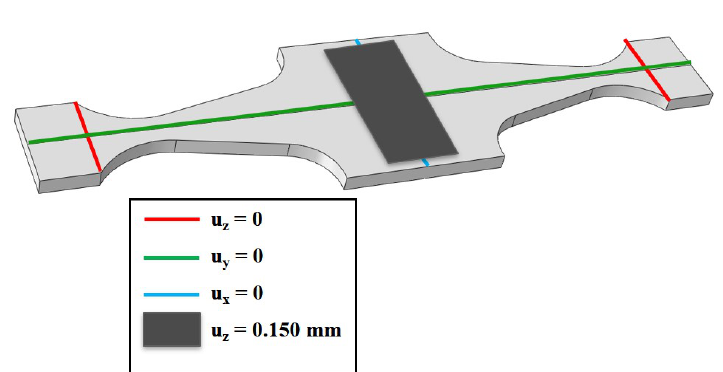
Figure 2. FEA simulation setup for wrought 304 stainless steel specimen.